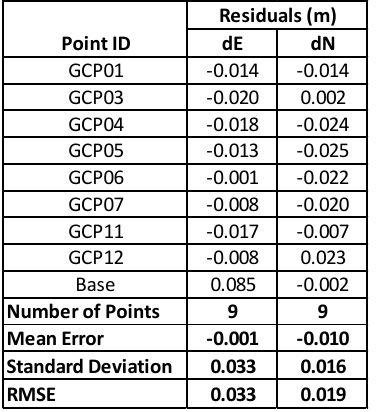
Table 3: Orthomosaic Check Point Residuals, Flight